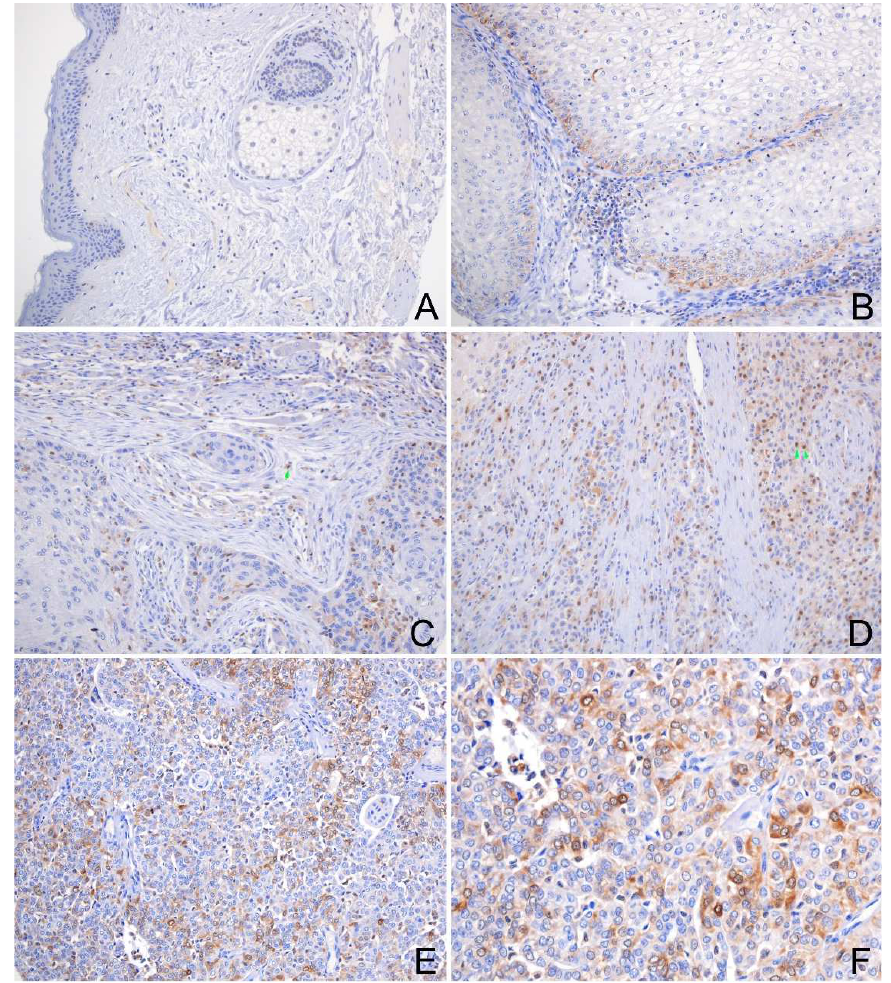
Figure 5. Representative photomicrographs of FAM49B expression in the normal oral epithelium and HNSCC tissues. ( A ) Shows negative expression of FAM49B protein in the normal oral squamous epithelium, hair follicle, and sebaceous glands; ( B ) Shows positive staining of FAM49B protein in the tumor cells around the nest of well-differentiated SCC; ( C ) Shows focal staining of FAM49B protein in the moderately differentiated SCC and immune cells (green arrow). ( D ) Shows positive staining of FAM49B protein in the immune cells of SCC (green arrow), which were localized in the cytoplasm and nuclear; ( E , F ) Shows positive staining of FAM49B protein in the tumor cells of poorly differentiated SCC. ( A – E , original magnification ×200; F, ×400).